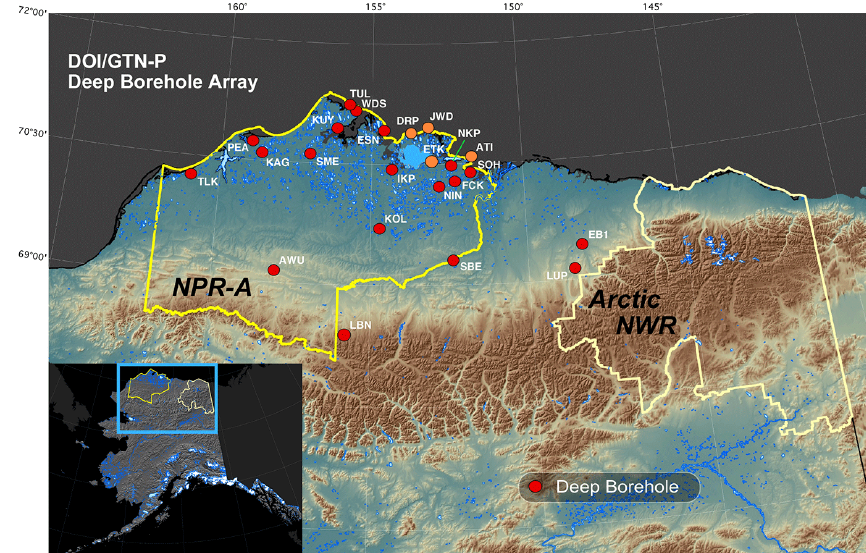
Figure 1. Location of the 23 DOI/GTN-P boreholes used to monitor the thermal state of permafrost (TSP) in the National Petroleum Reserve–Alaska (NPR-A) and near the Arctic National Wildlife Refuge. Wells indicated by orange symbols have been plugged and are no longer accessible.